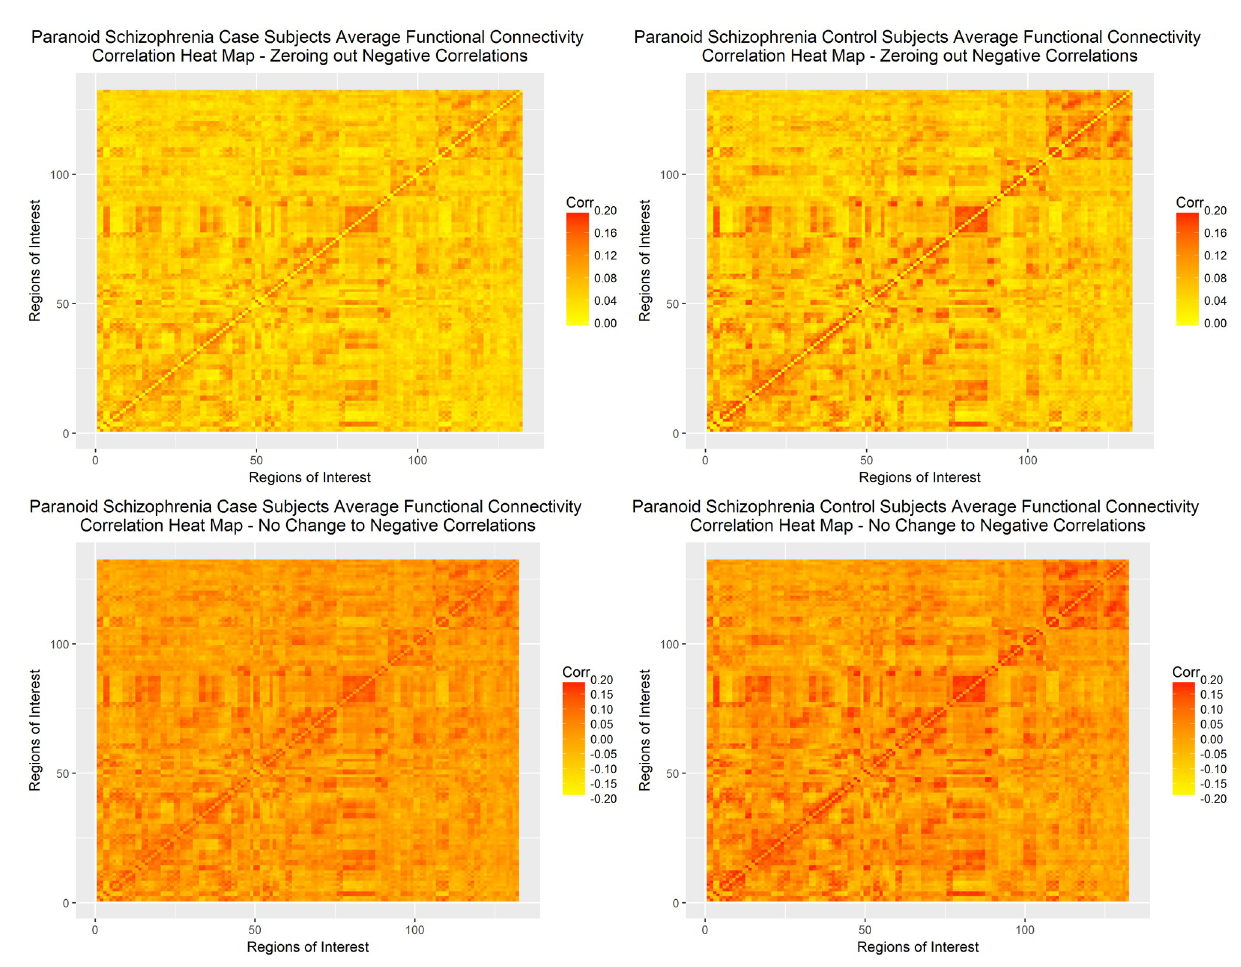
Fig 9. Correlation heat maps paranoid schizophrenia COBRE-I dataset. Correlation heat maps of control and schizophrenia subjects for only the paranoid schizophrenia subset under zeroing out negative correlations (top row) and normalizing all correlations (bottom row).